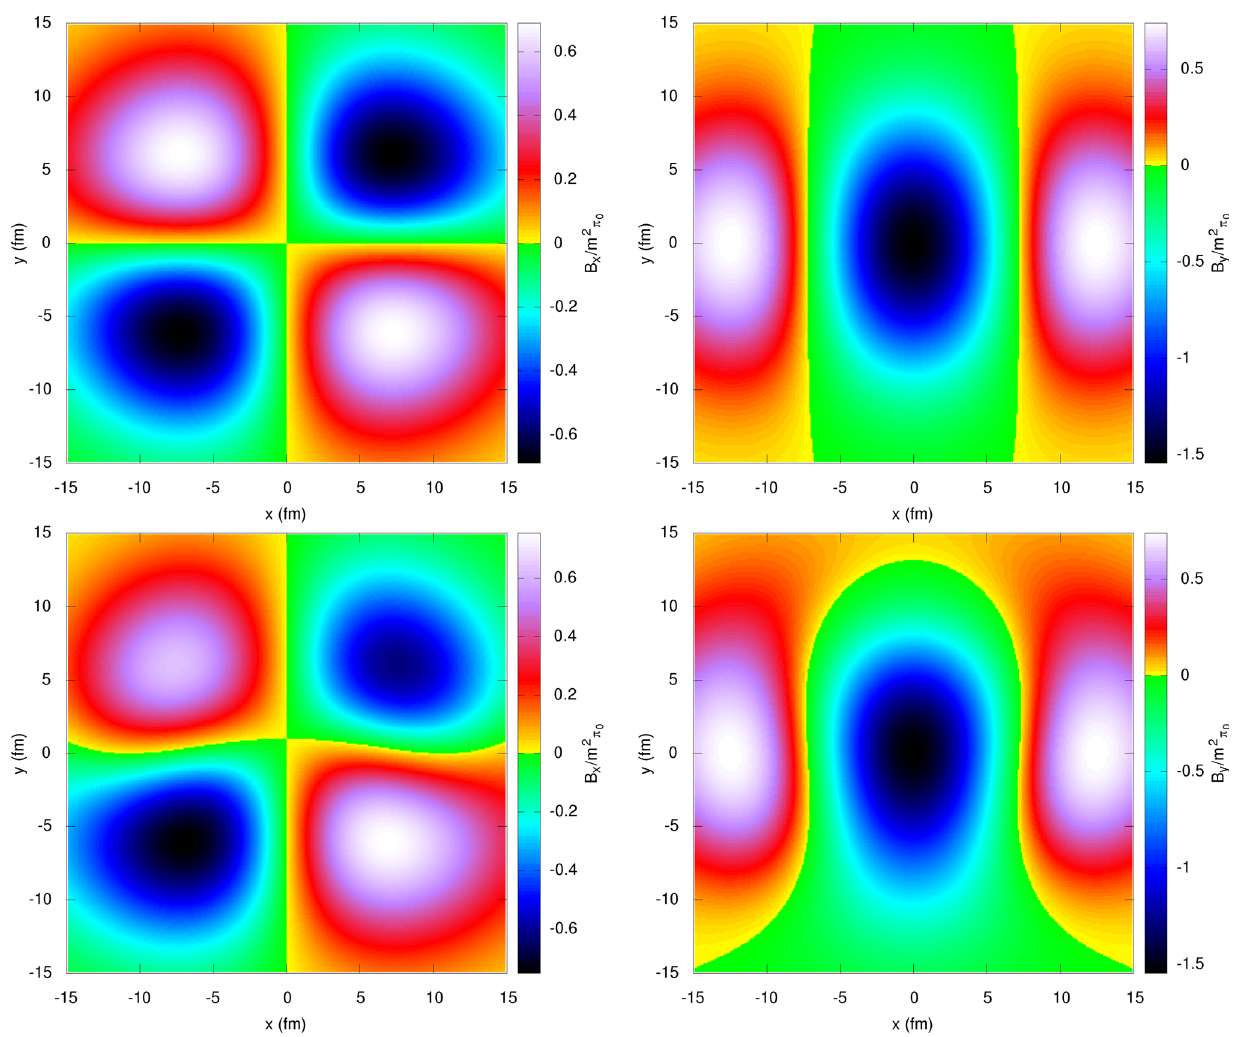
√ s NN = 200GeV with an impact parameter b = 12fm, assuming a at medium with constant electricalconductivity σ = 5 . 8MeV and a chiral magnetic conductivity σ χ = 1 . 5MeV